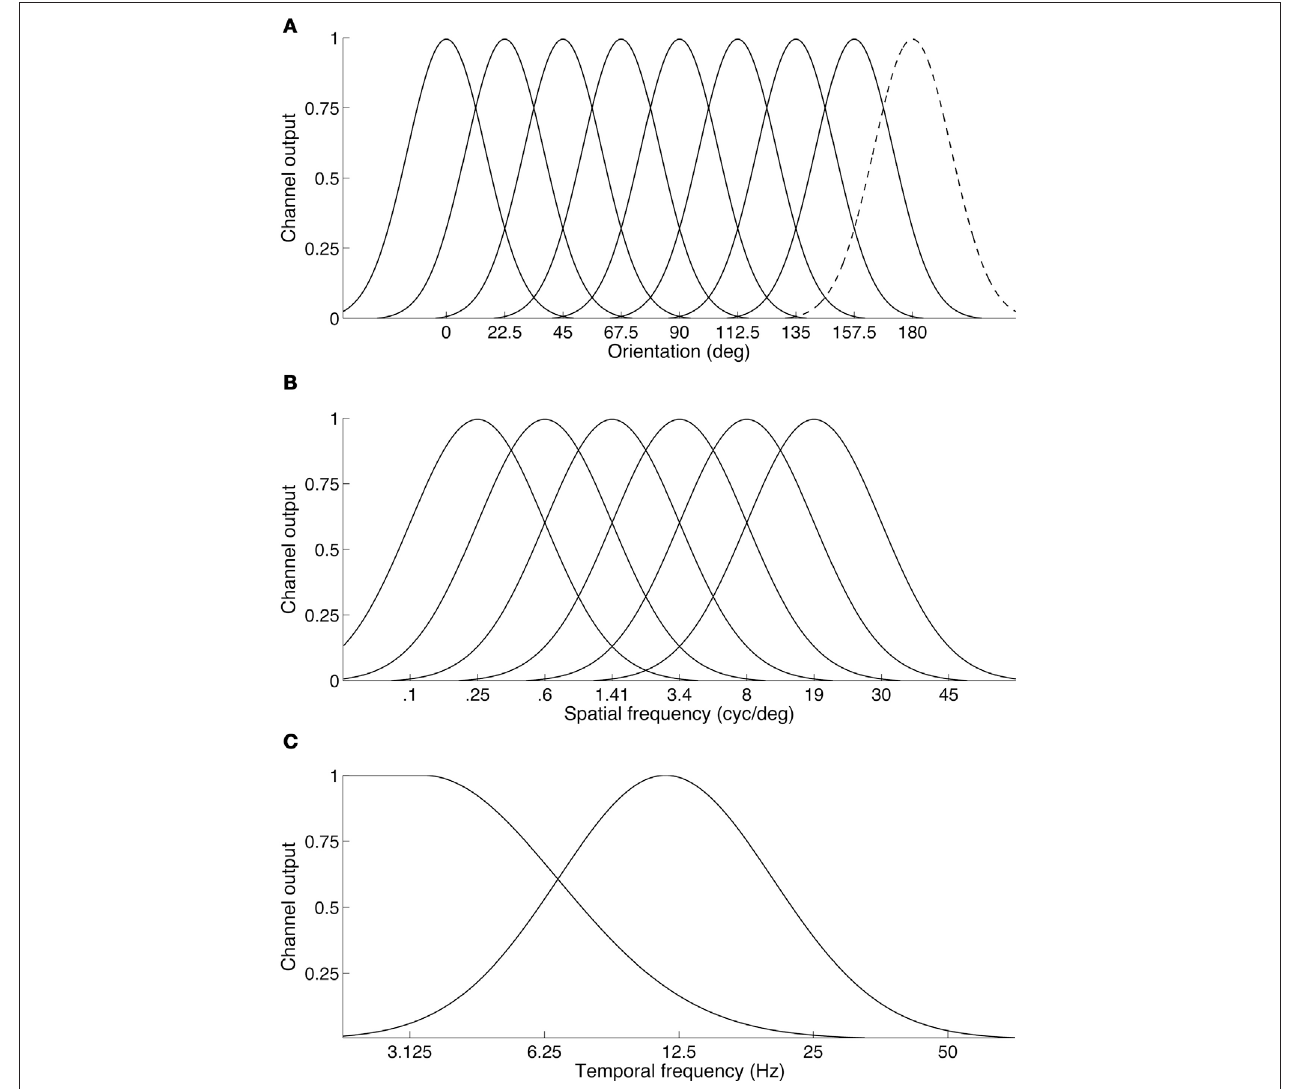
dimension. The channels shown here have a standard deviation of 1.25 octaves. On a log frequency axis, the channels are modeled as Gaussian normal curves. (C) Temporal frequency channels: consistent with many studies, two channels are shown on a log temporal frequency axis, a broad low-pass channel and a high bandpass channel. Some studies suggest a third, very high bandpass channel may also